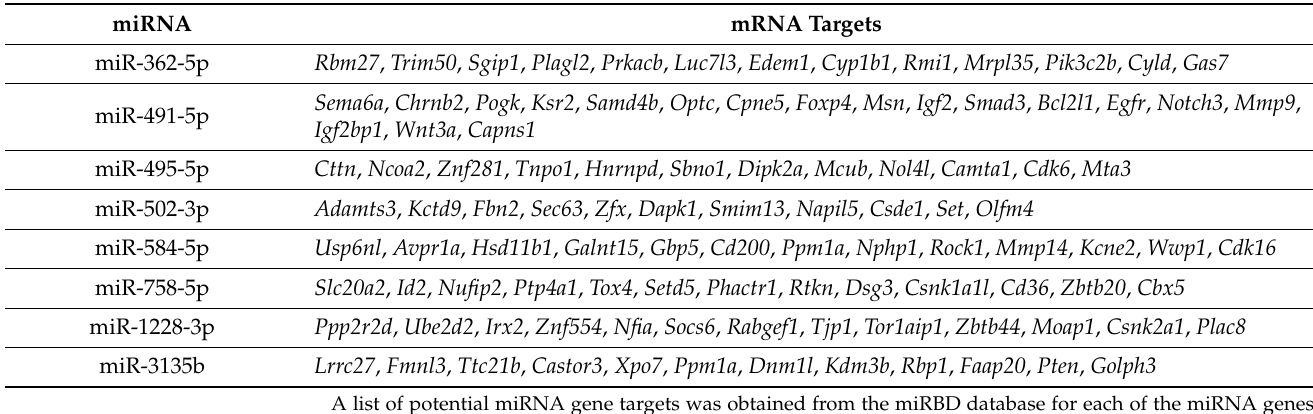
Table 2. A list of top mRNA targets for selected radiation-induced miRNA.